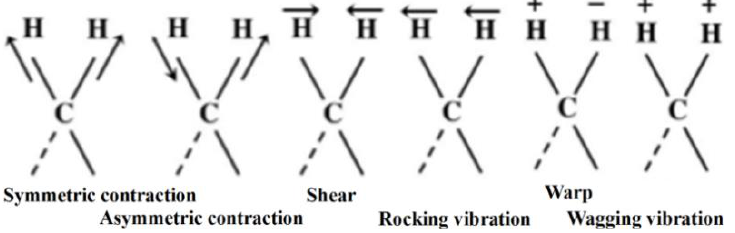
Figure 1. Examples of stretching vibrations and deformation vibrations of the measured material molecules (+ is vertical motion with paper facing inward, and − is vertical motion with paper facing outward).